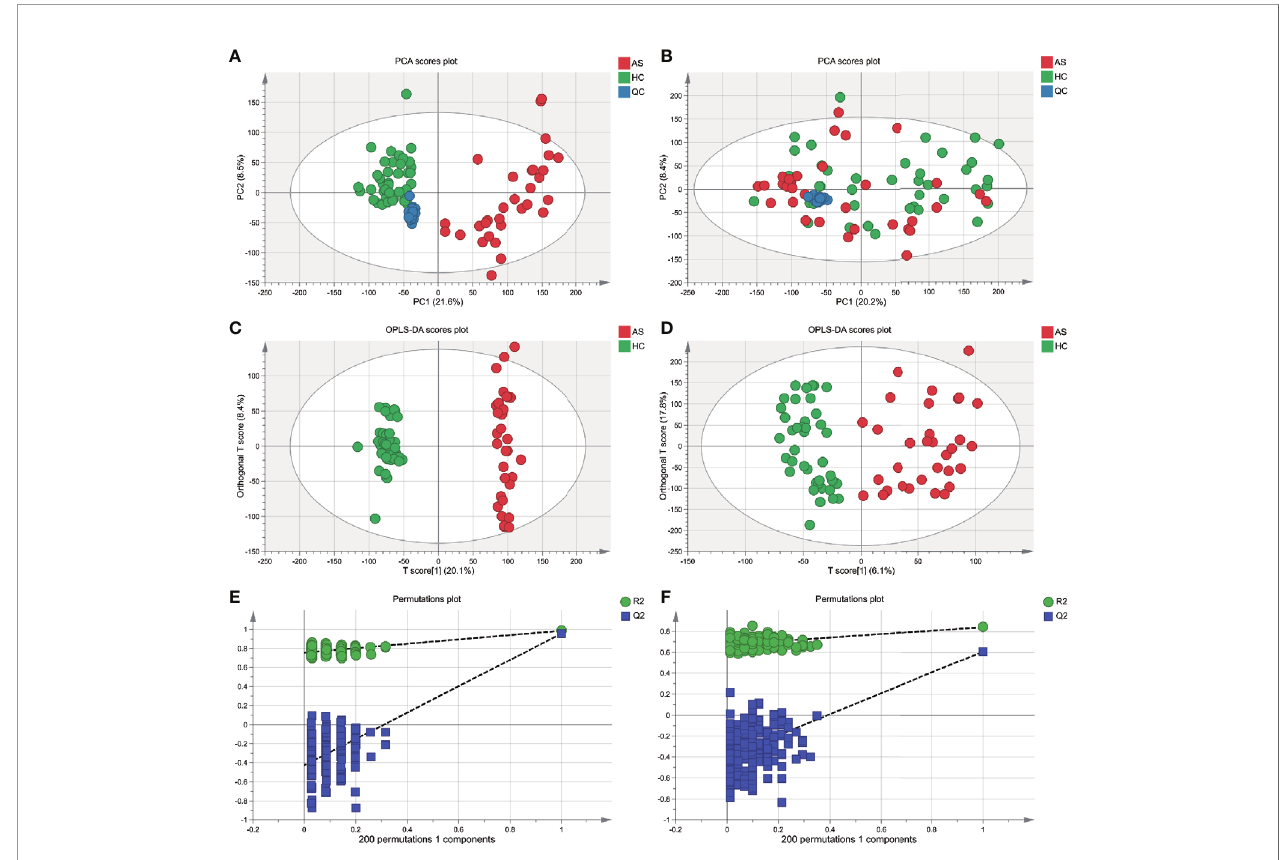
FIGURE 2 | Multivariate statistical analysis of serum metabolites in ankylosing spondylitis patients (AS) and healthy controls (HCs). (A, B) The scatter plots of principal component analysis (PCA) were based on the serum metabolic data in positive and negative ion mode. AS patients and HCs were denoted with red and green circles, respectively. The QC samples (blue circles) were clustered together in two modes. (C, D) Orthogonal partial least-squares discriminant analysis (OPLS- DA) scatter plots were based on the serum metabolic pro fi les in positive and negative ion mode. (E, F) The statistical validation of the corresponding OPLS-DA models by permutation tests (200 times).